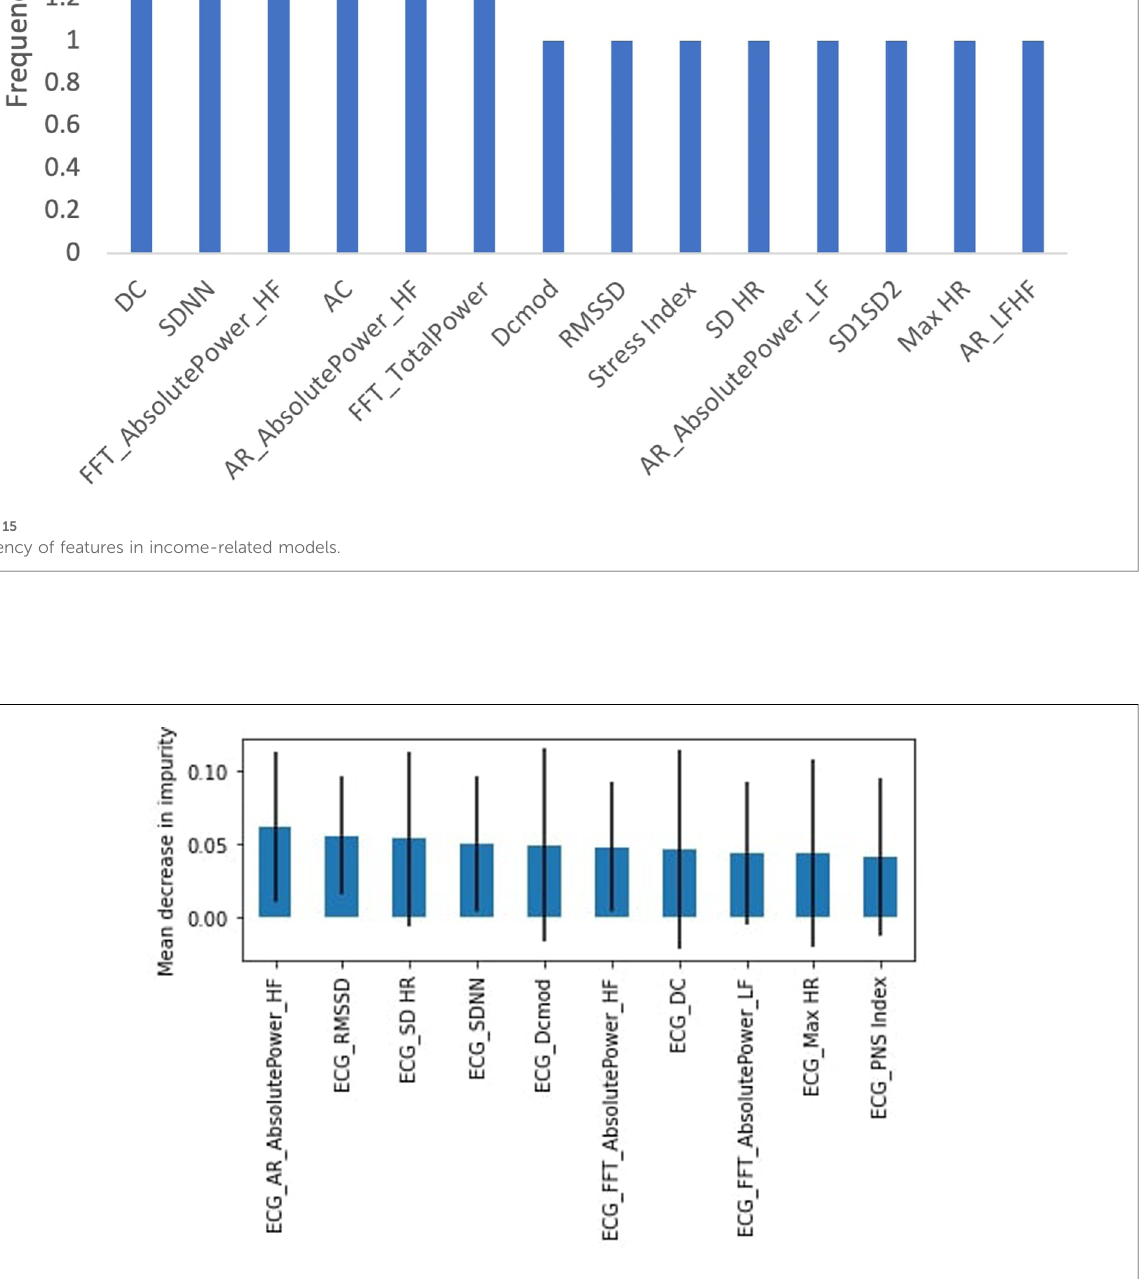
FIGURE 16 RF feature importance,